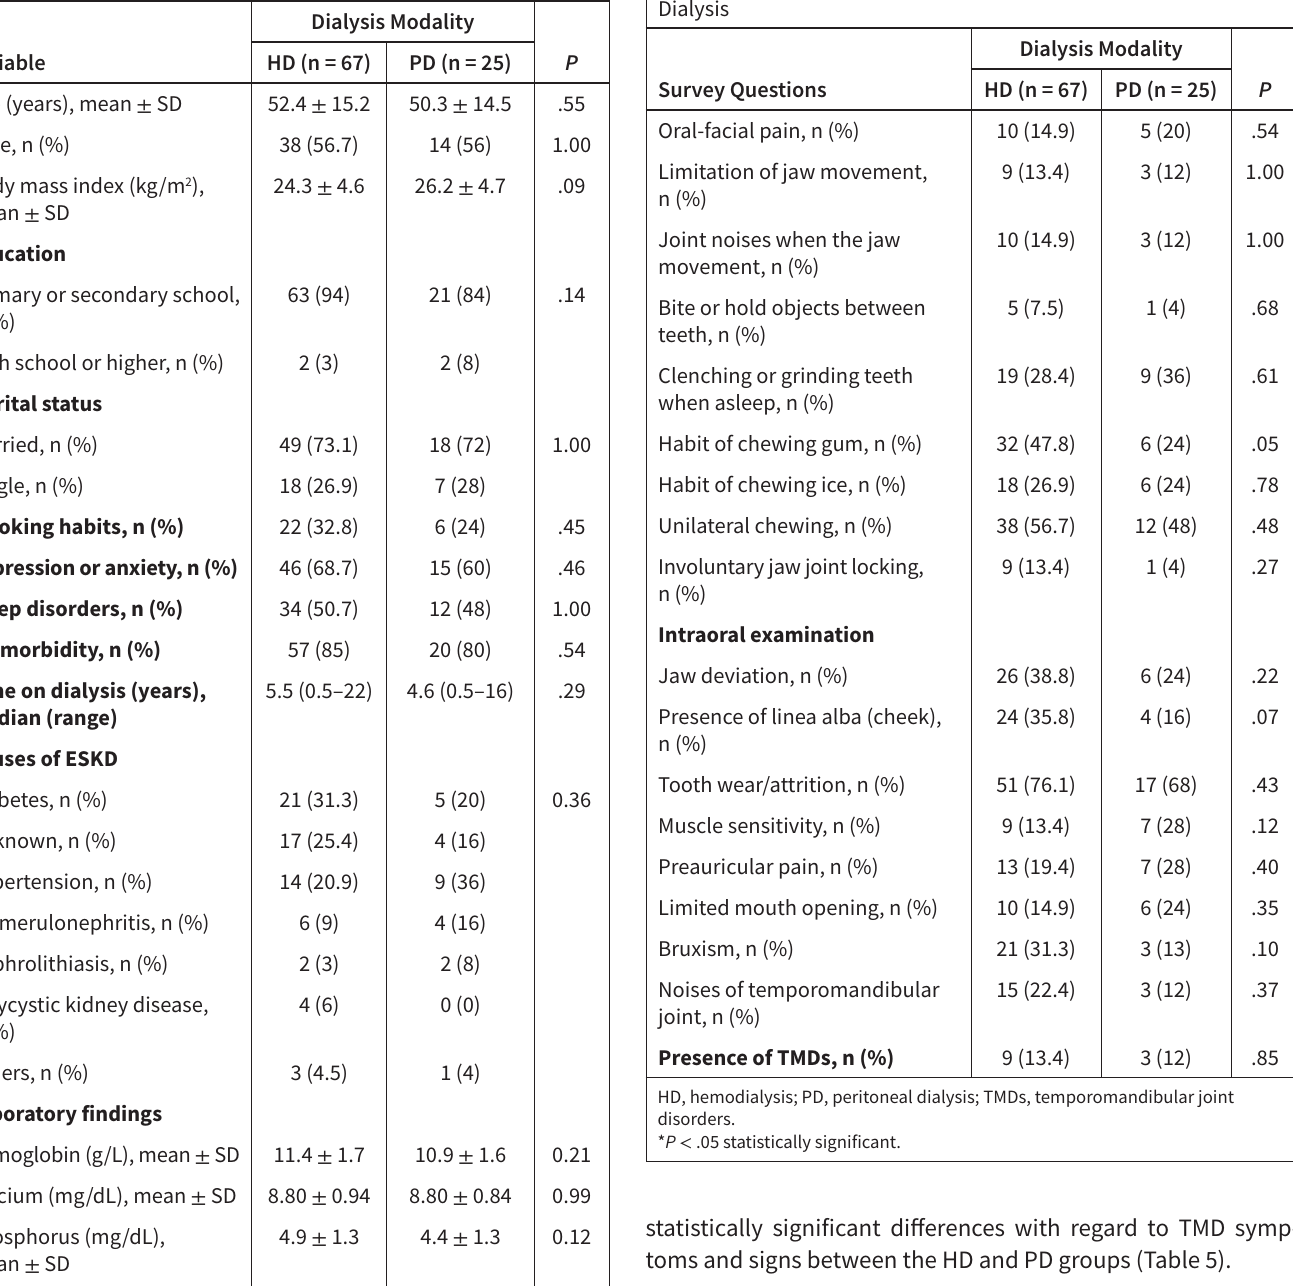
Table 4. Baseline Characteristics of Patients with End-Stage Kidney Disease